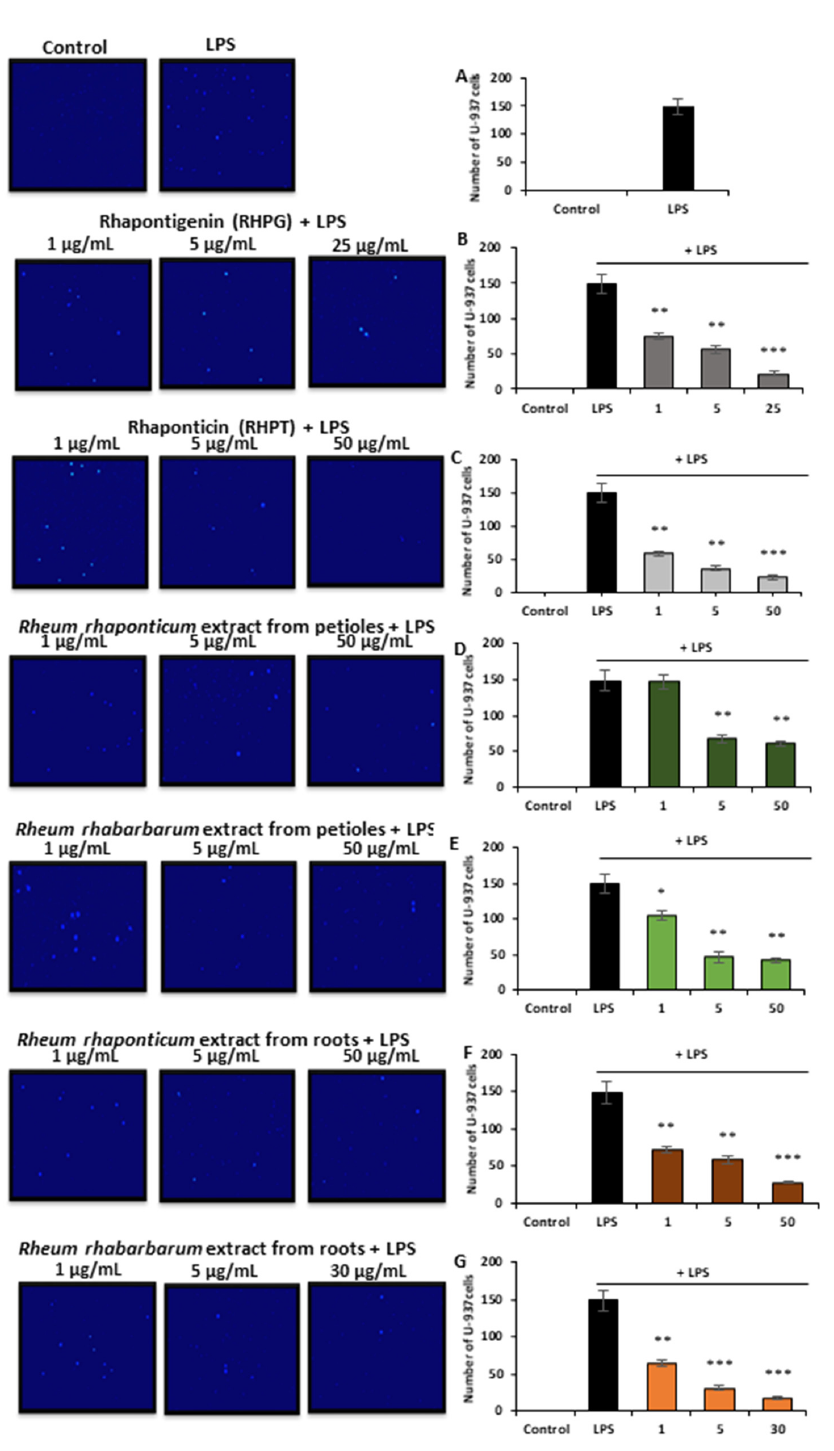
Figure 4. The effect of the examined rhubarb extracts and stilbenes on the recruitment of U-937 monocytes to the LPS-activated HUVECs. The image panel represents the pictures obtained from the fluorescence (UV) microscope; magnification 20 × . Calculations of the adhered monocytes have been presented as follows: control/untreated and LPS-treated cells ( A ), RHPG ( B ), RHPT ( C ), R. rhaponticum extract from the petioles ( D ), R. rhabarbarum extract from the petioles ( E ), R. rhaponticum extract from the roots ( F ), R. rhabarbarum extract from the roots ( G ). Data are presented as means ± SD; n = 3. Statistical significance (HUVECs pre-incubated with plant substances and activated by LPS versus HUVECs activated by LPS in the absence of the examined substances): * p < 0.05, ** p < 0.01, *** p <